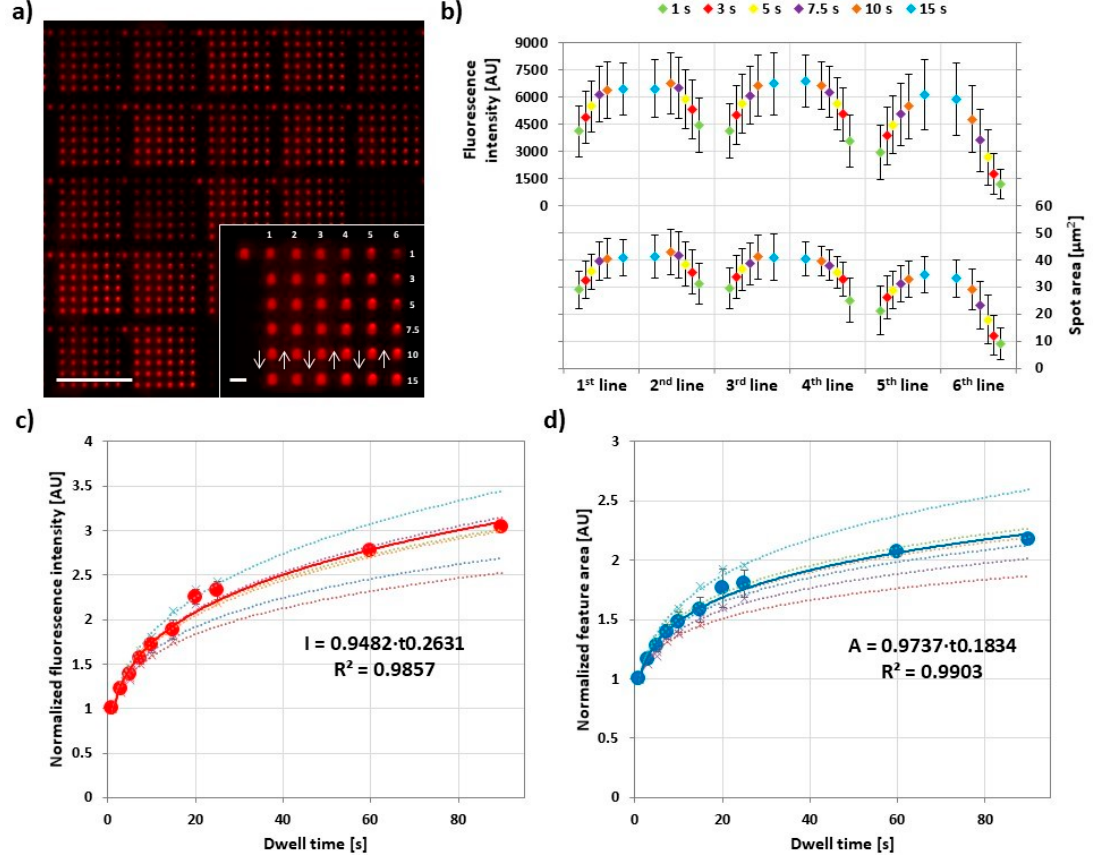
Figure 3. Influence of dwell time on lipid ink transfer. ( a ) Representative fluorescence micrograph of the 6 × 6 arrays designed to analyze the amount of transferred lipid in dependence of dwell time. The inset shows higher magnification of a single array, along with the printing scheme. The scale bars equal 100 µ m in the main panel and 10 µ m in the inset; ( b ) Plots of the average intensity (above) and area (below) of corresponding spots (same line and same dwell time) in 30 analyzed arrays against the dwell time per line; ( c , d ) show plots of the normalized average intensity (red) and area (blue), respectively, of spots against dwell time combined from six independent experiments (data were normalized to the 1 s dwell time value, the original data without normalization are shown in Figure S5). The background plots (connected by dashed curves) show the normalized data from the single experiments for reproducibility evaluation. All the printings were performed under 40% relative humidity (RH) and room temperature. The reproducibility of the printed substrates was proofed by comparing the average areas and intensities among the six independent experiments, as shown in Figure S6. Error bars represent standard deviation.